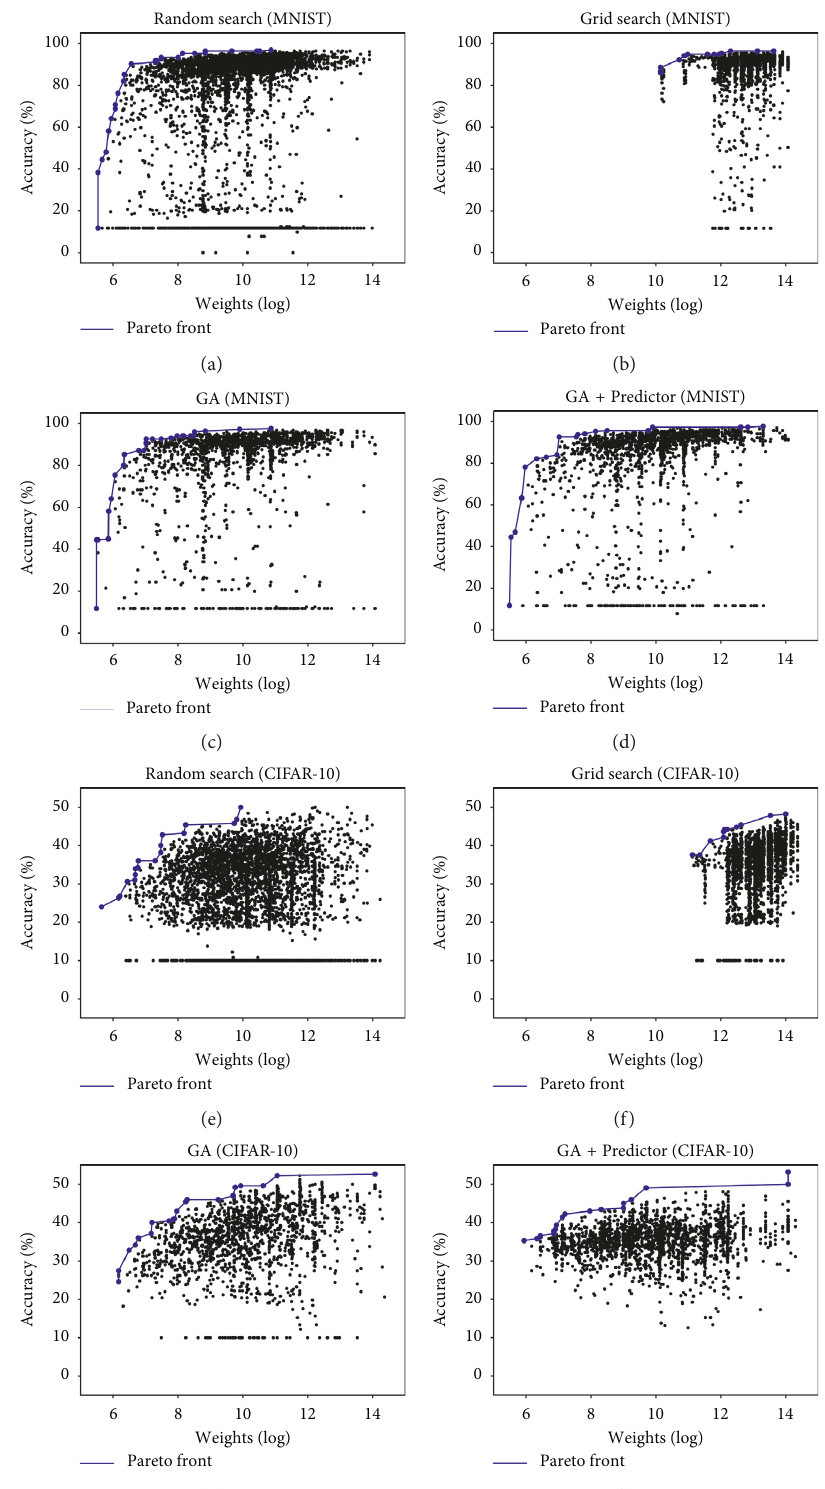
Figure 8: Pareto front obtained with each search method for the MNIST and CIFAR-10